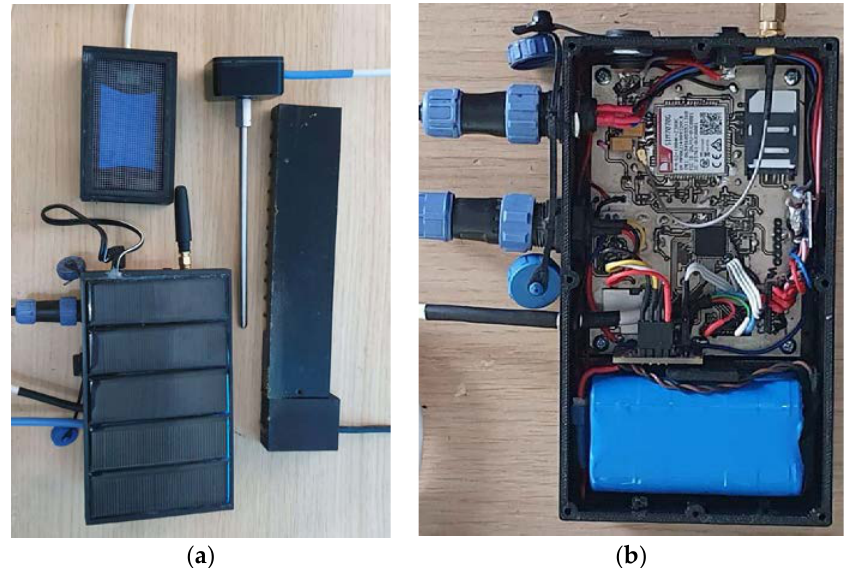
Figure 3. ( a ): the central monitoring unit in the center of the picture with some of the sensing modalities attached. All sensors are sampled simultaneously, and their readings are collected from the main CPU. ( b ): a closer look at the electronics board prototype. One can discern the CPU in the center, the GPU and communications modem on top, the SD card on top right, the battery on the bottom that connects to the solar